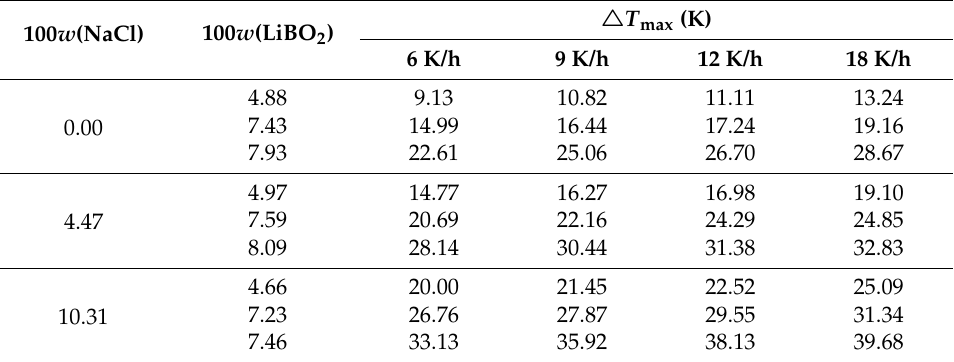
Table 3. Width of lithium metaborate salts with different cooling rates and a different impurity